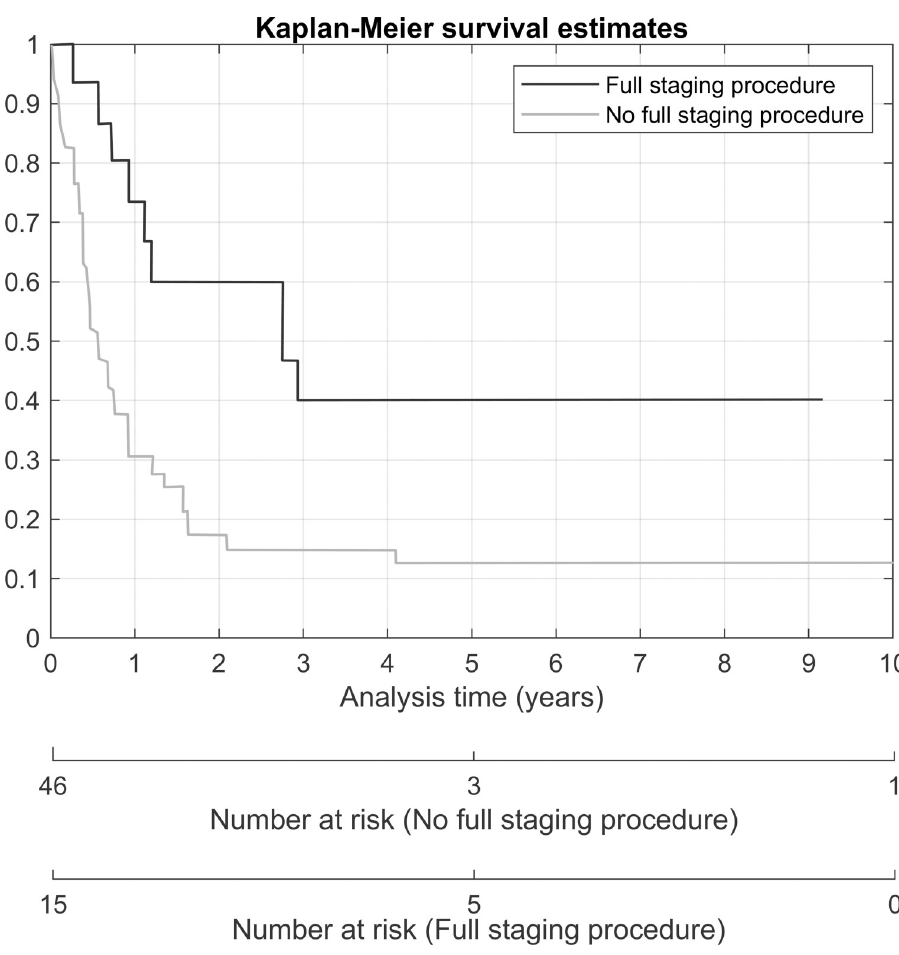
Fig 4. Overall survival according to receiving a full staging